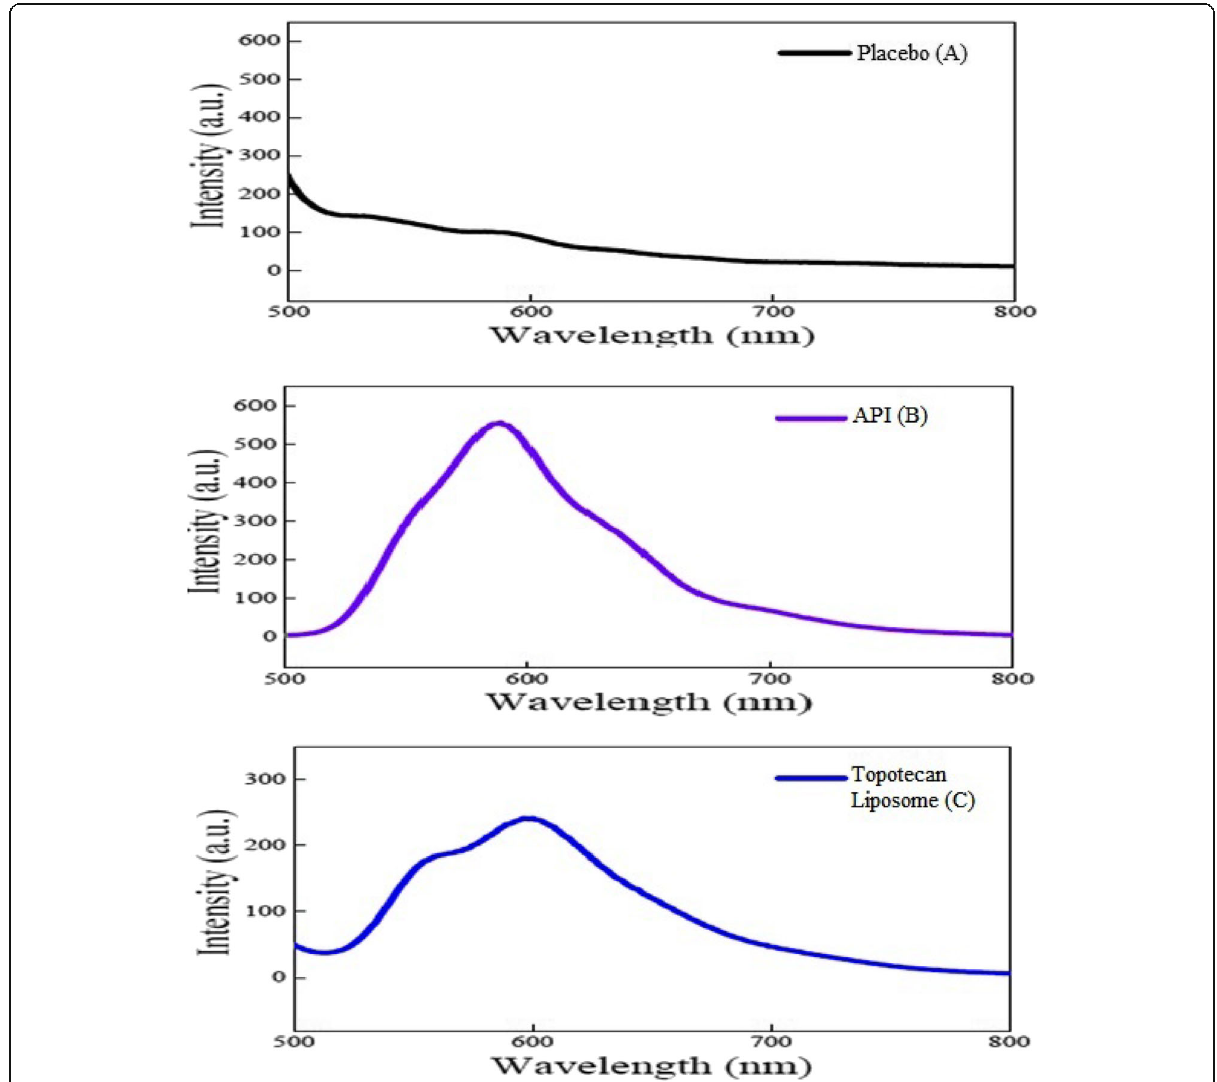
Fig. 1 a Fluorescence spectra of placebo. b Fluorescence spectra of API. c Fluorescence spectra of topotecan liposome